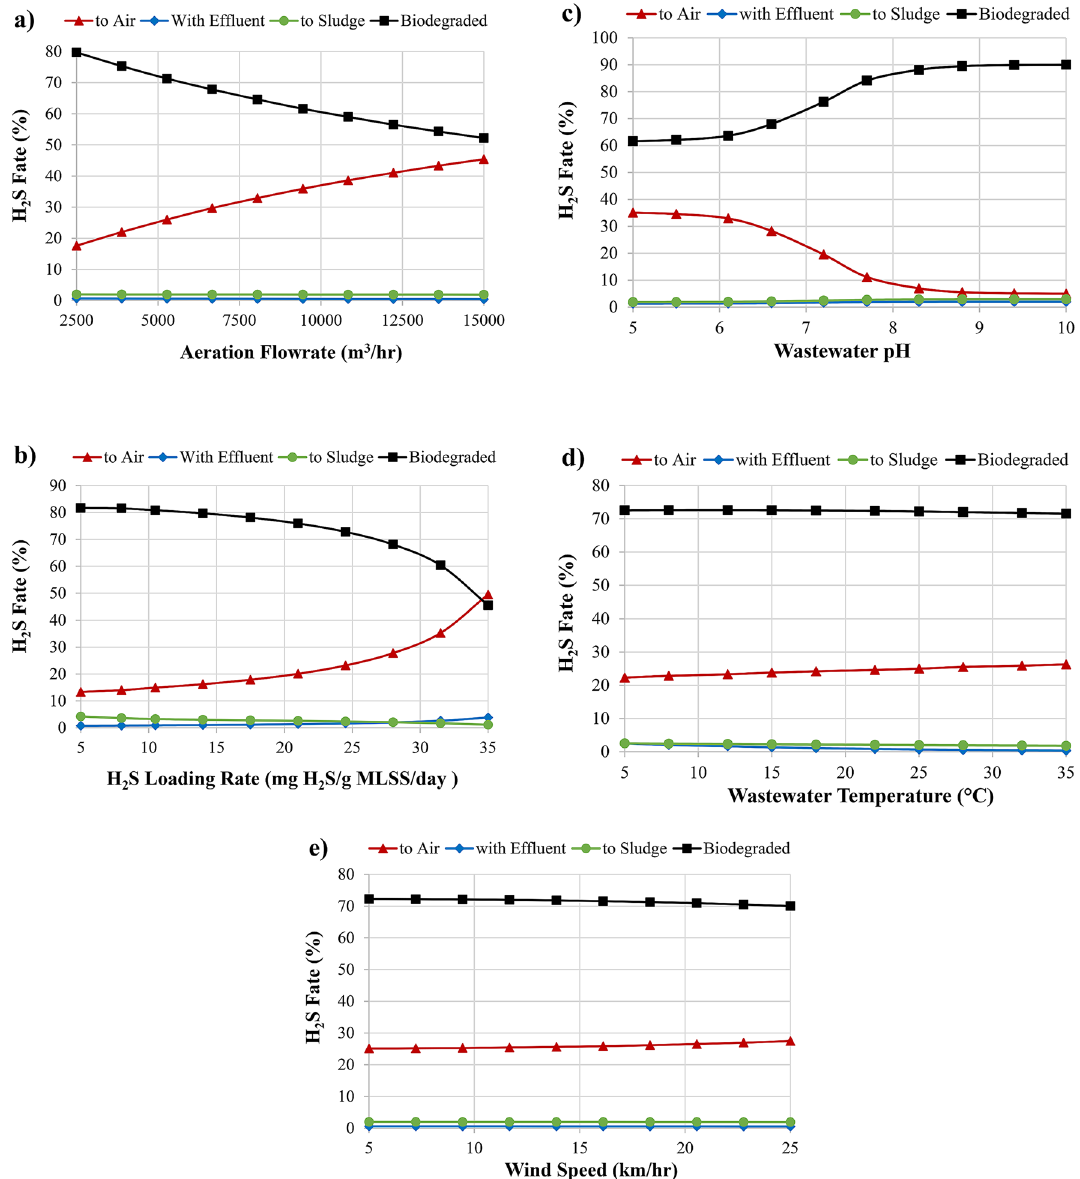
Figure 6. Sensitivity analysis of different H 2 S dispersion: ( a ) aeration flowrate, ( b ) MLSS concentration, ( c ) wastewater pH level, ( d ) wastewater temperature, and ( e ) wind